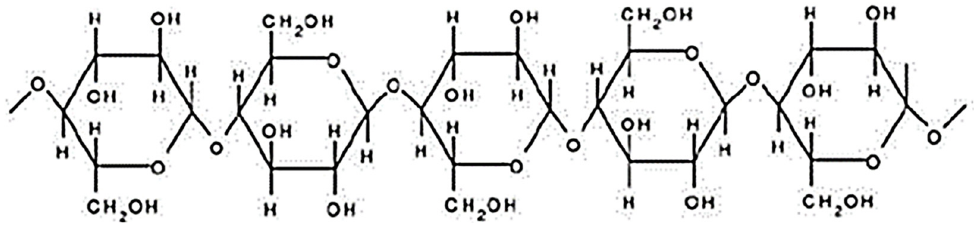
Figure 14. Chemical structure of cellulose molecule [9].